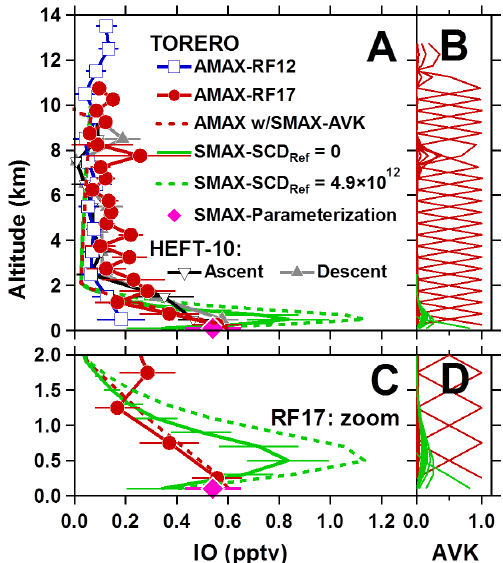
Figure 9. IO vertical profiles and comparison with independent validation data on the ship. (a) AMAX-DOAS during RF12 (blue squares) and RF17 (red dots) is compared with SMAX-DOAS pa- rameterization (magenta diamond) and optimal estimation retrievals (green lines). (b) shows AVK for glyoxal from RF17 (red) and SMAX-DOAS (green). (c) is the same as (a) but with only RF17 data and zoomed for the lower 2km. SMAX profile inversion of dSCDs is the solid green line; SCD REF = 4 . 9 × 10 12 moleccm − 2 IO is the dashed green line; simulated SMAX-DOAS view of the AMAX profile using Eq. (2) is the red dashed line; see Sect. 3.4 “Sensitivity of MAX-DOAS profiles to SCD REF ” for details. (d) is the same as (b) , zoomed for the lower 2km. The error bars are based on propagating fit errors through the